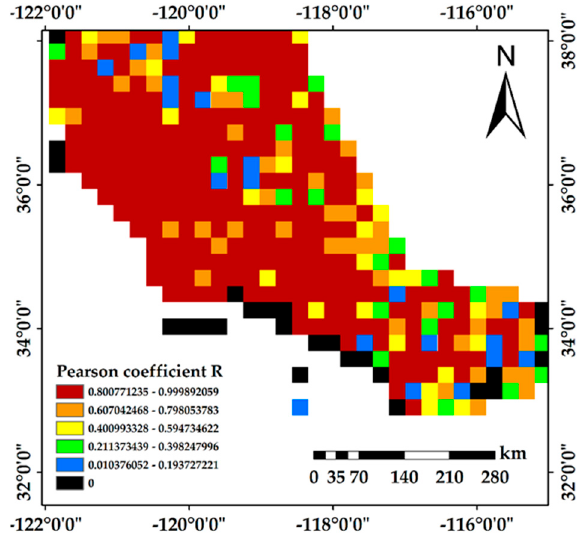
Figure 9. Correlation distribution between GA − BP Inversion soil moisture and NASA − USDA products for site 392. Table 6. Pearson’s coefficient R statistics for site 392.